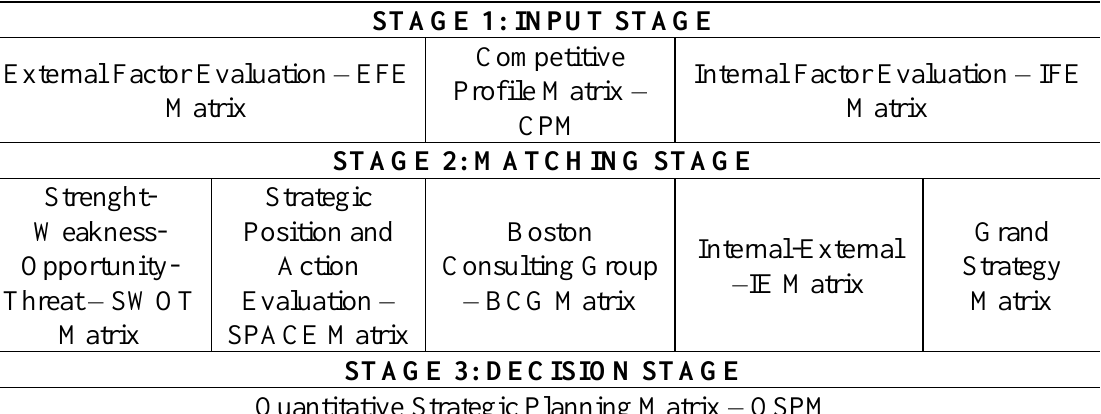
Figure 1. Comprehensive Strategy Formulation